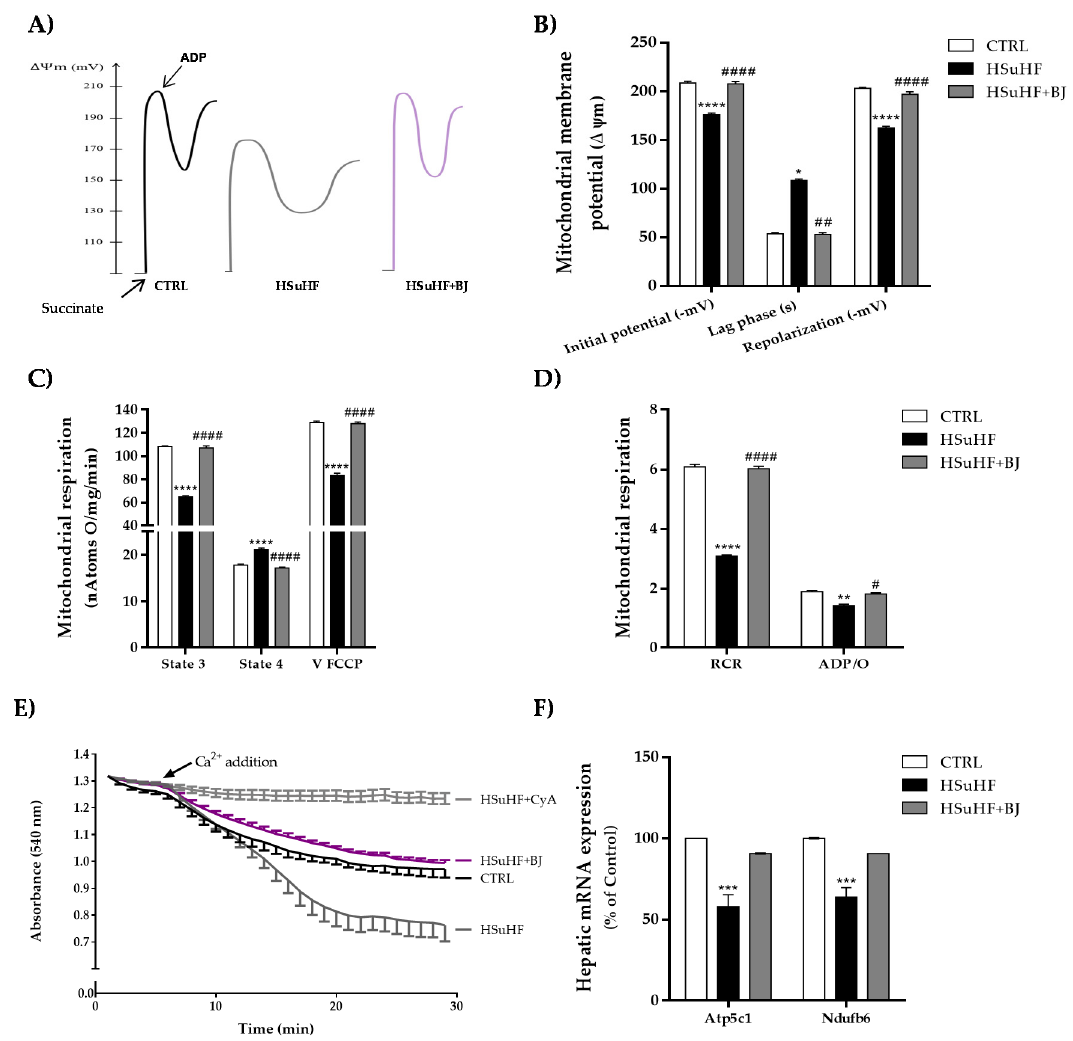
Figure 5. Effects of BJ on mitochondrial function parameters, including mitochondrial membrane potentials and lag phase ( A , B), mitochondrial respiration parameters ( C , D ), and susceptibility to the induction of mitochondrial permeability transition (MPT) ( E ); hepatic mRNA expression of genes involved in the mitochondrial electron transport chain ( F ). Results are expressed as the mean ± SEM. ( n = 6–8/group). * p < 0.05, ** p < 0.01, *** p < 0.001, and **** p < 0.0001 vs. CTRL group; # p < 0.05, ## p <0.01, and #### p < 0.0001 vs. HSuHF group. CTRL: control. HSuHF: high sucrose/high-fat. BJ: blueberry juice. FCCP: carbonylcyanide-P-trifluoromethoxyphenylhydrazone. RCR: respiratory control ratio. ADP/O: adenosine diphosphate to oxygen ratio.